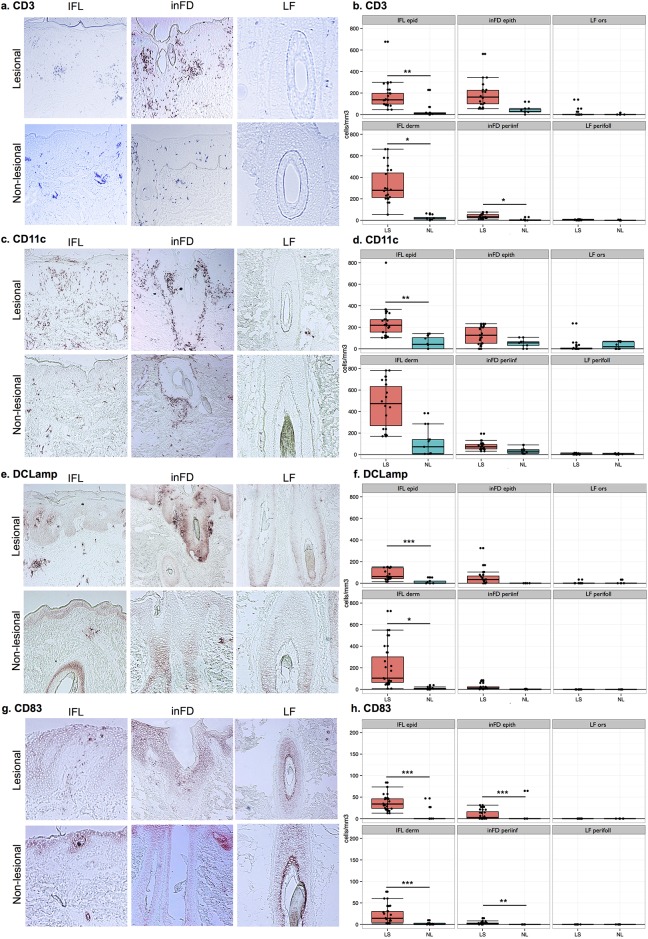
Distribution and number of CD3+, CD11c+, DC-Lamp+ and CD83+ cells in the various compartments of the study groups.Panels a, c, e and g show the histological pictures. Graphs b, d, f and h show the number of cells and statistical analysis. IFL, interfolicular; inFD, infundibular; LF, low follicule; Epid, epidermis; Epith, epithelium; Ors, outer root sheath; Periinf, periinfundibular area; Perifoll, perifollicular area. Cells were counted per mm2 epidermis and dermis in the IFL area. Median and ranges of log transformed values are given. Statistics: <0.05 = *; p<0.01 = **; p<0.001 = ***.